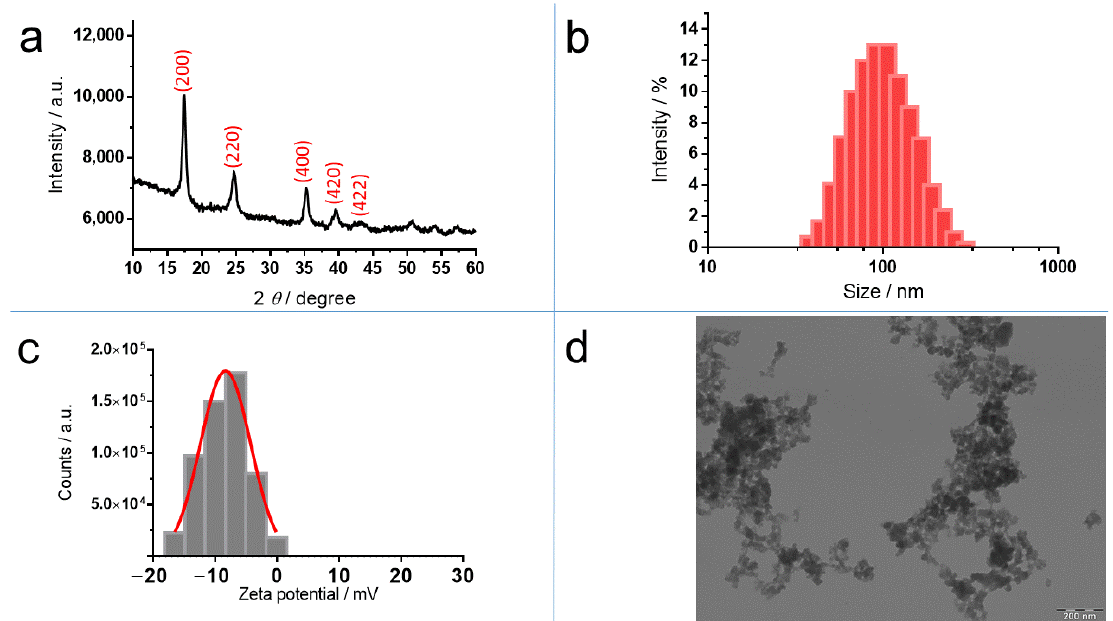
Figure 2. Characterization of PB nanoparticles: ( a ) X–Ray diffraction (XRD) pattern; ( b ) size distribution determined by dynamic light scattering ( c ) ζ-potential distribution measured by Doppler electrophoresis and ( d ) transmission electron microscopy (TEM) image.